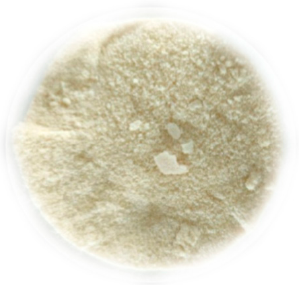
Figure 1. The appearance of the extracted germinated brown rice.